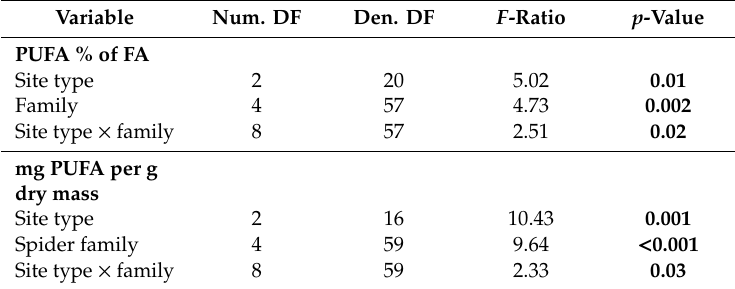
Table 1. Results of mixed-e ff ects model ANOVAs testing site type, spider family and their interaction on PUFAs (% of total FA and mg PUFA per g dry mass).